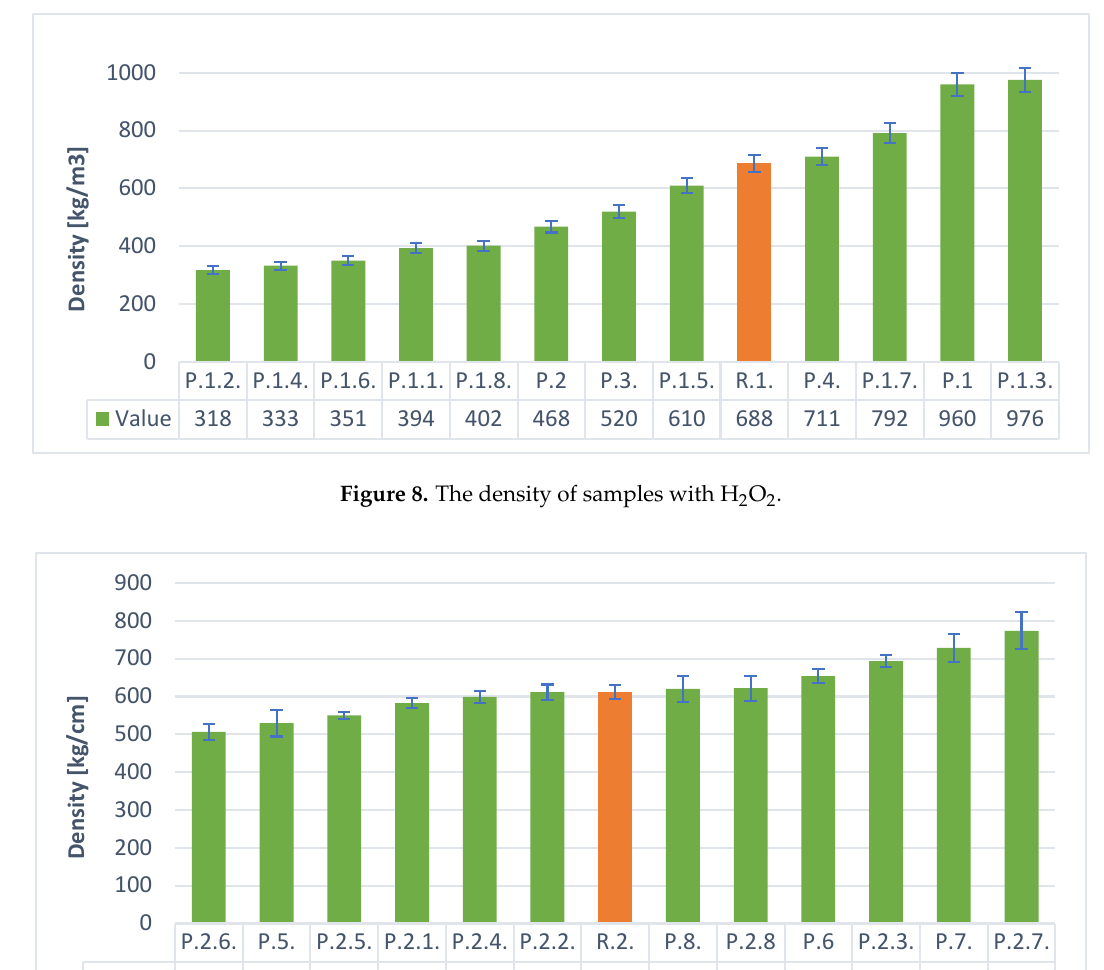
Figure 8. The density of samples with H 2 O 2 . Figure 9. The density of samples with aluminum. Figure 9. The density of samples with